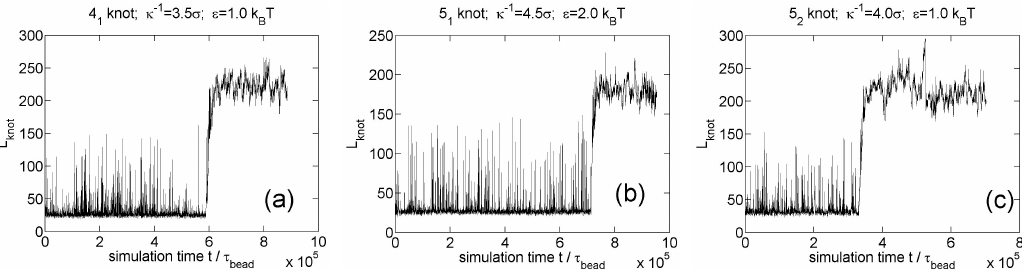
Figure 9. Knot breathing for other knot types in simulations of circular flexible chains with 300 monomers and Yukawa potentials. ( a ) 4 1 knot; ( b ) 5 1 knot; ( c ) 5 2